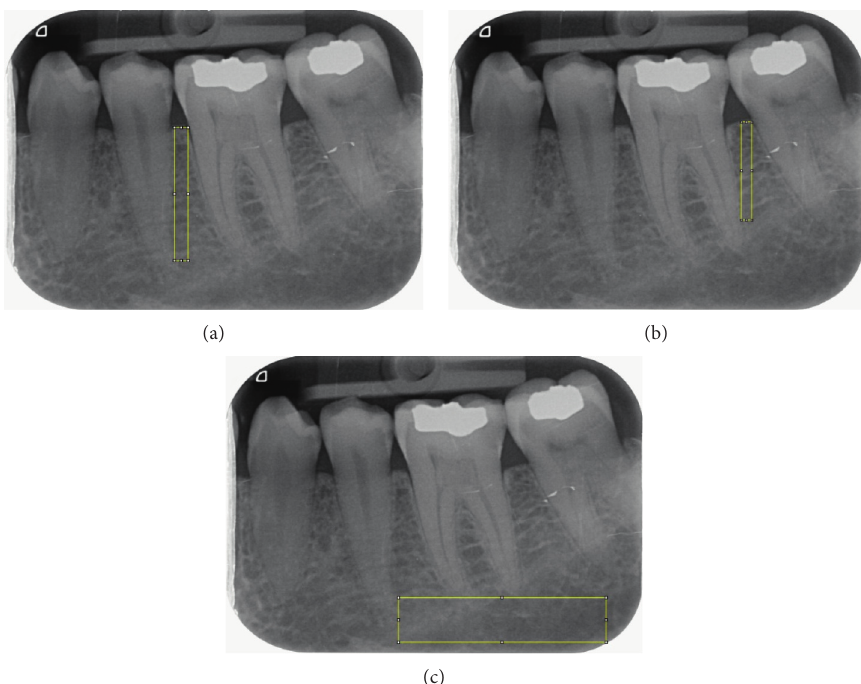
Figure 1: Selected regions of interest (ROIs) in periapical images: (a) mesial ROI, (b) distal ROI, and (c) apical ROI.